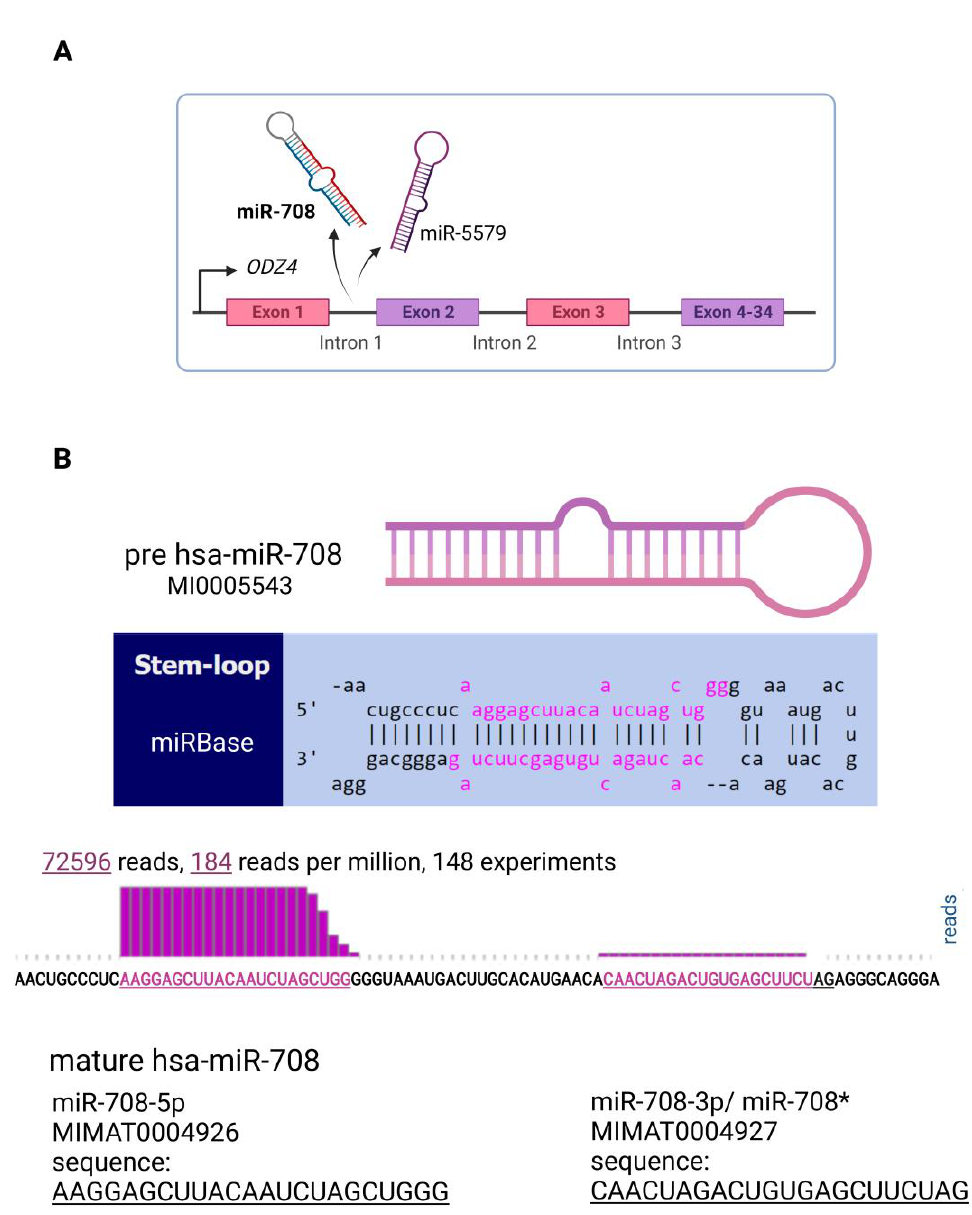
Figure 1. ( A ) Biogenesis of miR-708 and miR-5579 from intron 1 of the ODZ4 gene mapped on 11q14.1. ( B ) From miRBase data (MI0005543), hsa-miR-708 stem-loop sequence and mature (708-5p and 708-3p or miR-708*) are available. The histogram represents deep sequencing diagrams with the height of bars for each nucleotide corresponding to the normalized number of nucleotides from different reads mapping to that specific nucleotide. Pink letters indicate nucleotides contained within the mature sequences. Created with BioRender.com.